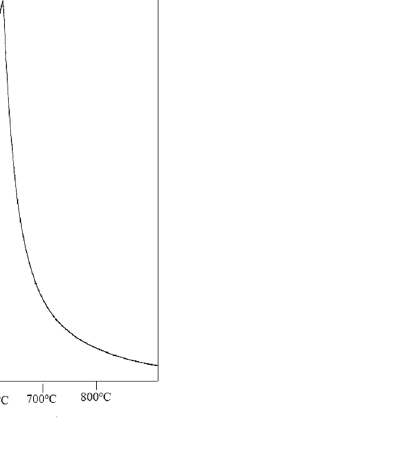
Figure 7. NH 3 -TPD of acid activated carbon